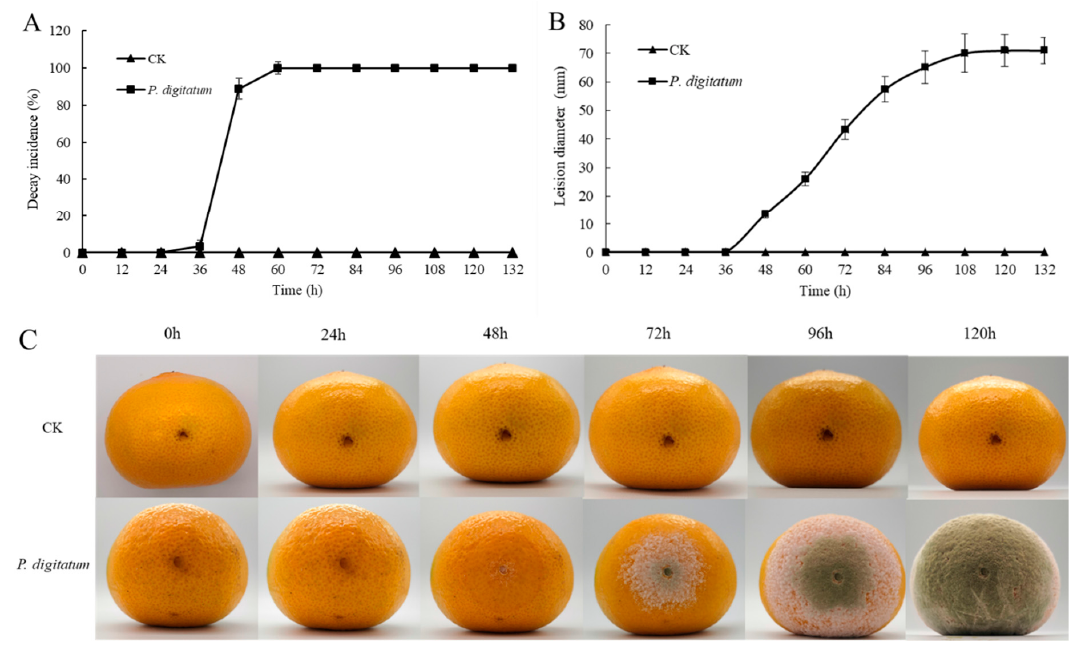
Figure 1. Infection of citrus by P. digitatum at 25 °C . ( A ): Decay incidence of citrus inoculated with P. digitatum ; ( B ): lesion diameter of citrus inoculated with P. digitatum ; ( C ) development of watery soft rot and green mold symptoms on citrus inoculated with P. digitatum in the same citrus. CK: Citrus inoculated with water. Each value is the mean of three experiments. Bars represent the standard deviation of the mean.